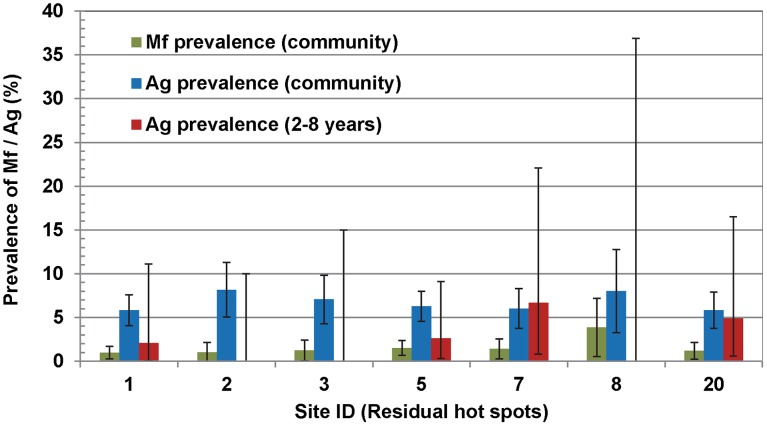
Prevalence of microfilaraemia (Mf) and antigenaemia (Ag) in the residual hotspots.Error bars are 95% confidence intervals.